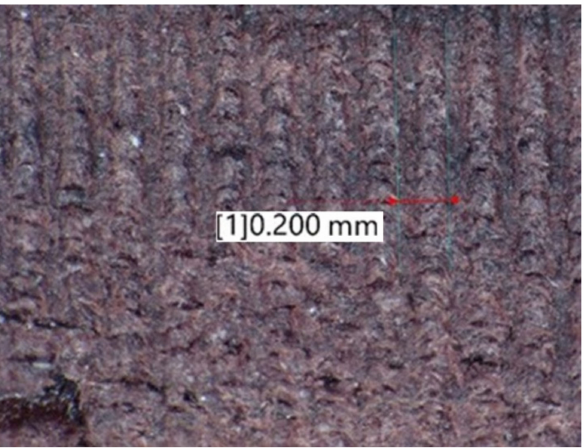
Figure 19. The macroscopic view of the surface of West African Ebony after turning with 3ER (TH) with an ap = 1.0 mm with the marked distance between successive depressions on the structure.